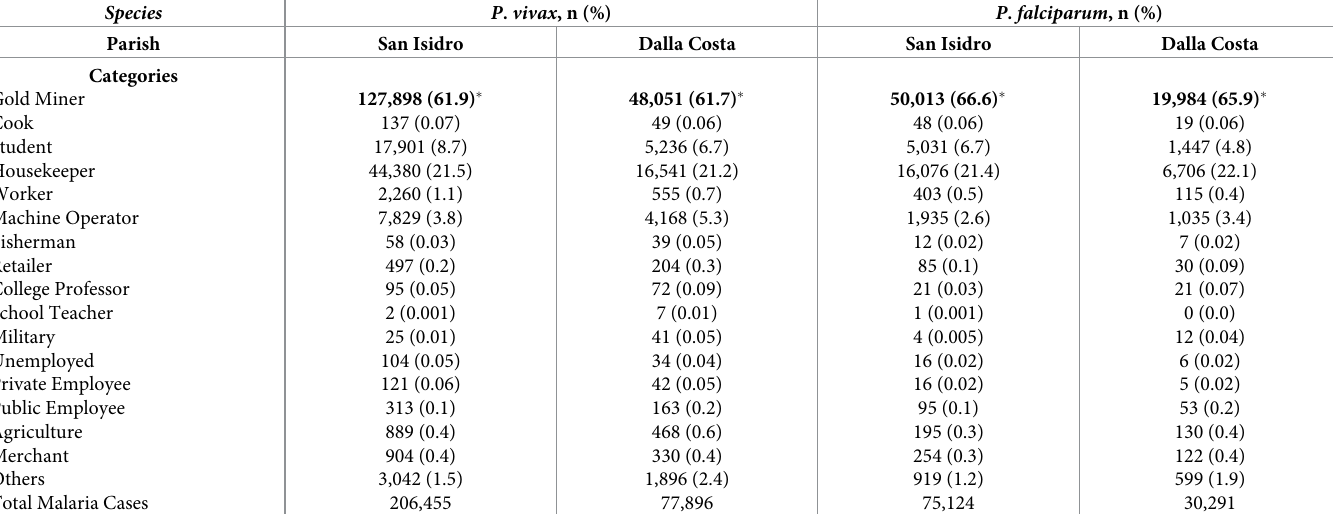
1 Values in the table (percentage) correspond to attributes of malaria-confirmed cases from the Malaria Control Program (Minister of Health) database of the two main malaria hotspots (Bolivar state, South-eastern Venezuela) during 2007–2017 period. � Bold figures indicate that malaria cases occurred predominantly ( X 2 -test, 1df, P < 0.0001) in miners (see the main text for